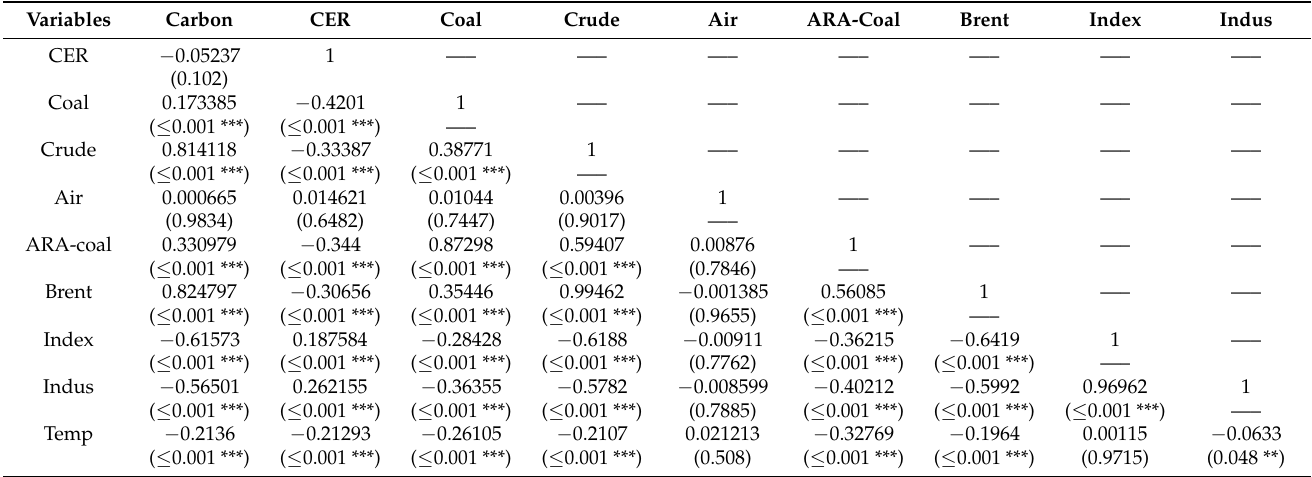
Table 6. Correlation test results.